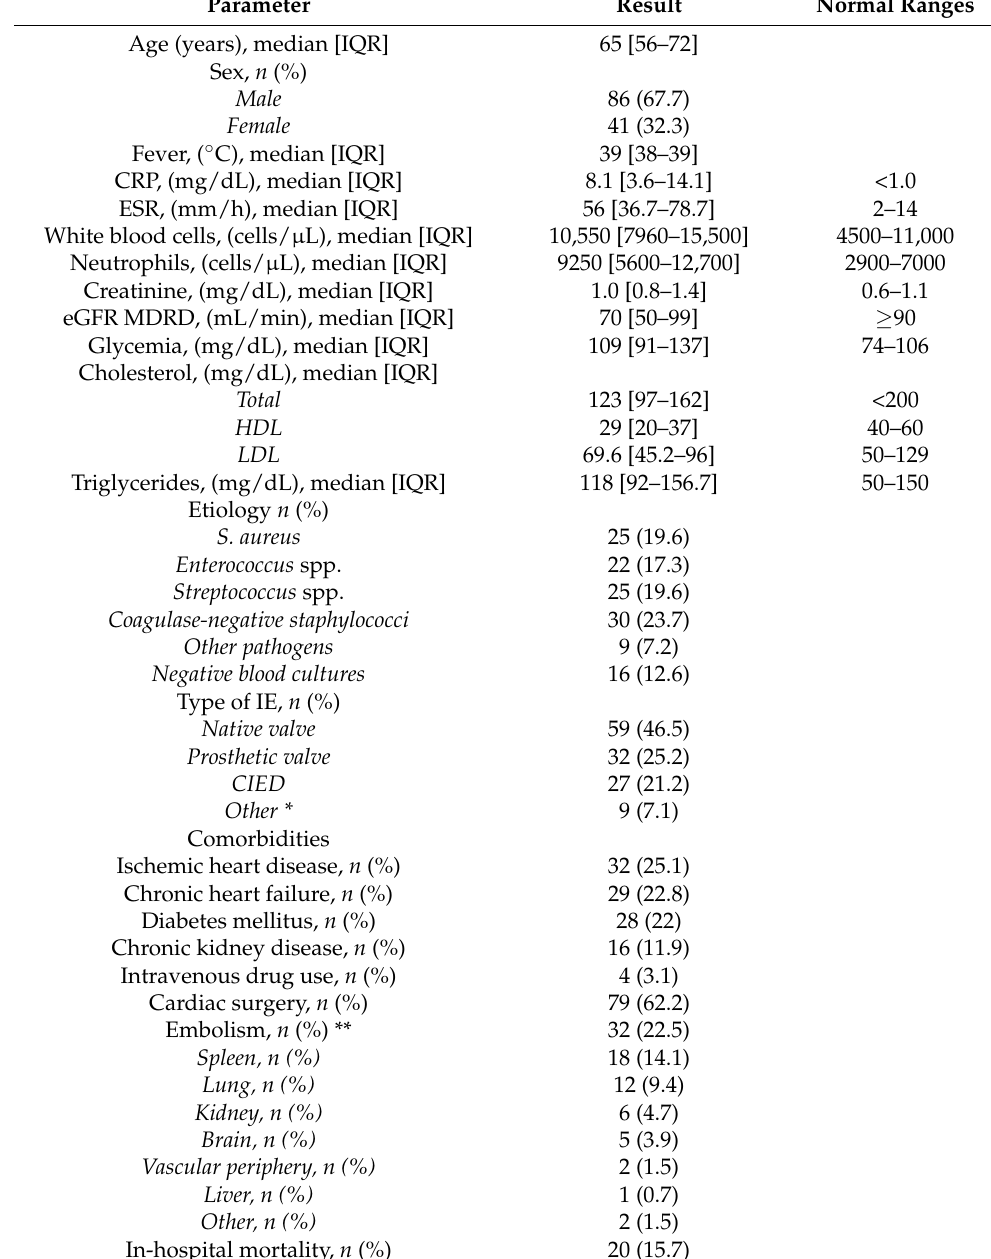
Table 1. Characteristics of the study cohort ( n =